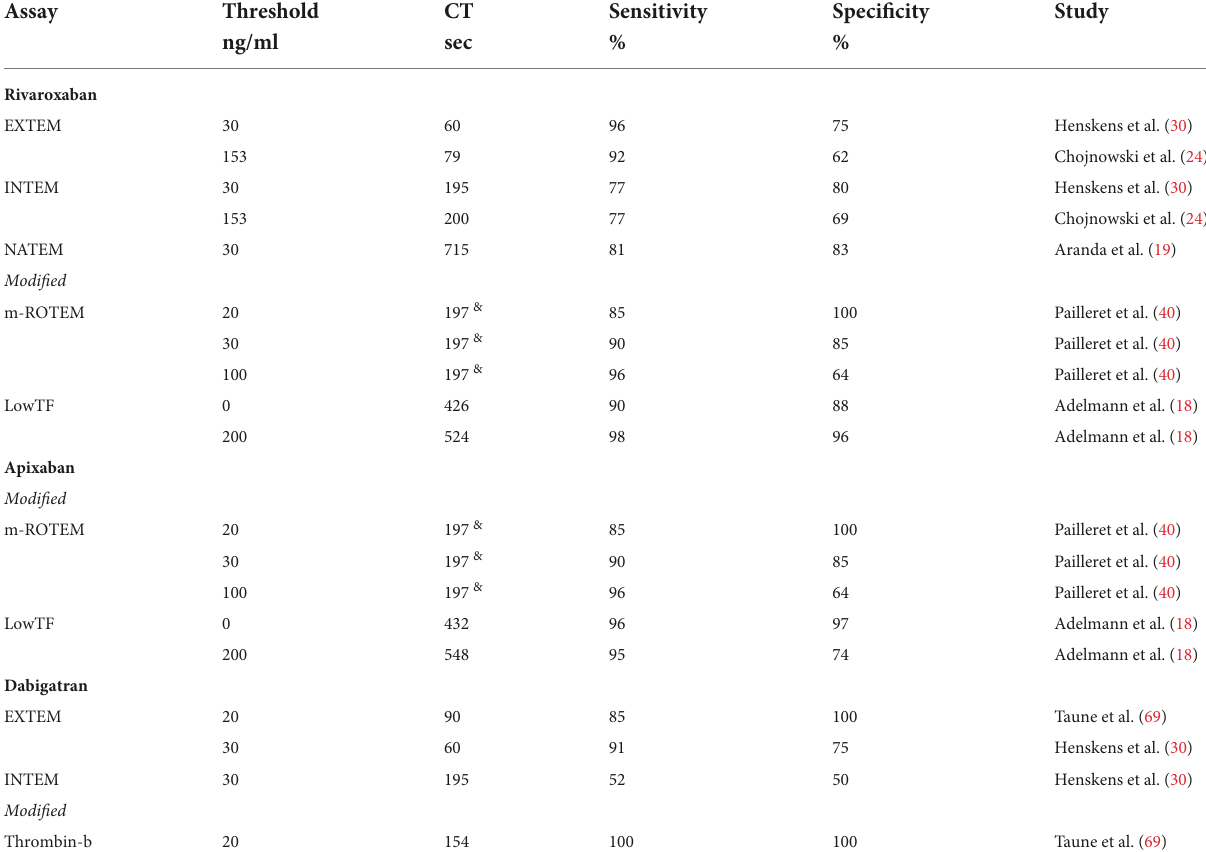
TABLE 1.1 Study defined ROTEM clotting time (CT) thresholds for detection of the residual DOAC plasma concentration stratified by assays.